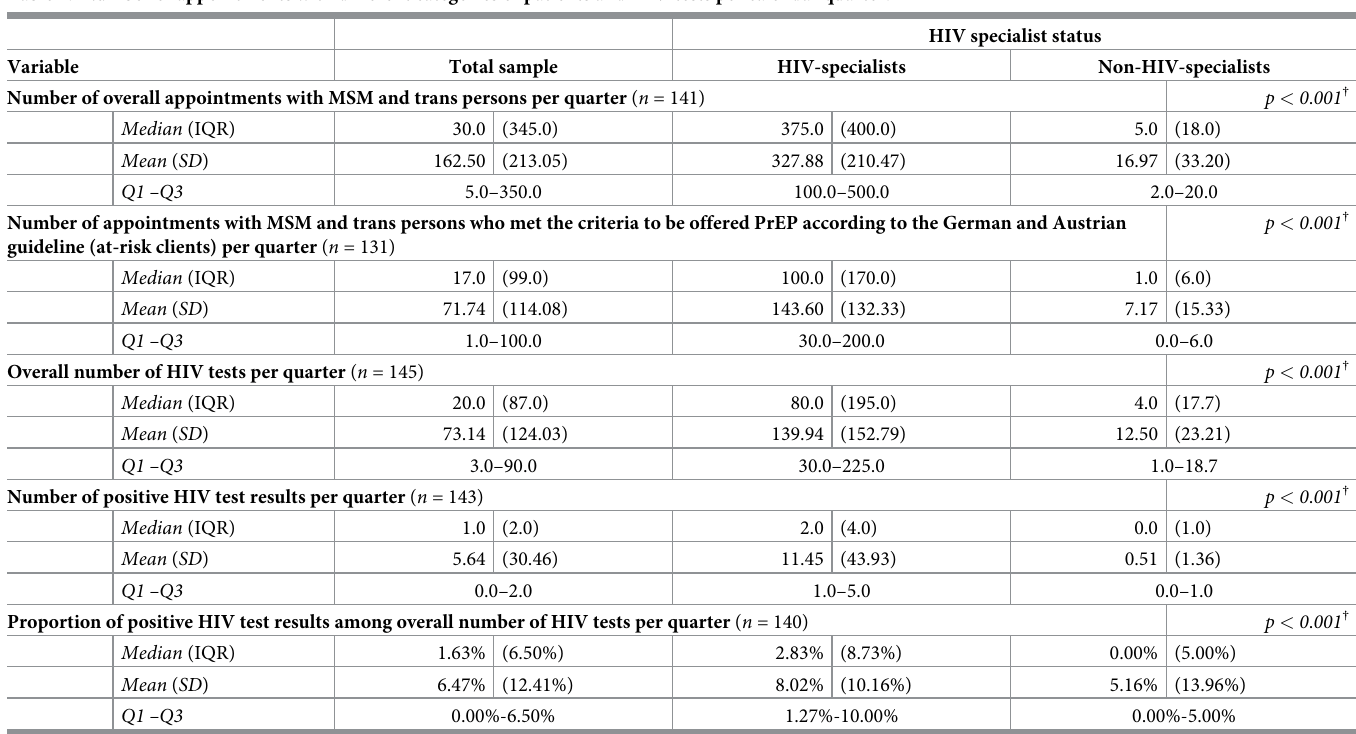
Table 2. Number of appointments with different categories of patients and HIV-tests per calendar quarter. HIV specialist status Total sample HIV-specialists